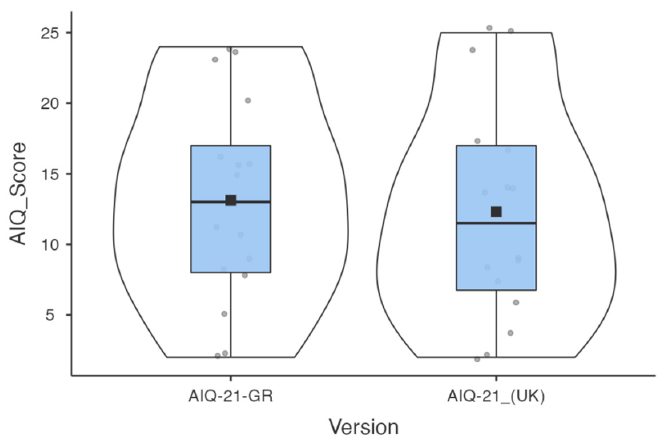
Figure 2. Violin Plot of the AIQ-21-GR vs. AIQ-21 (UK) scores for the final year bilingual SLT Students. Note: In Figure 2, the black line indicates the median, while the black square shows the mean for the scores of the final year SLT students in the Greek version of the AIQ-21 (left) and the original English version AIQ-21(right). The grey dots indicate individual scores for each version.